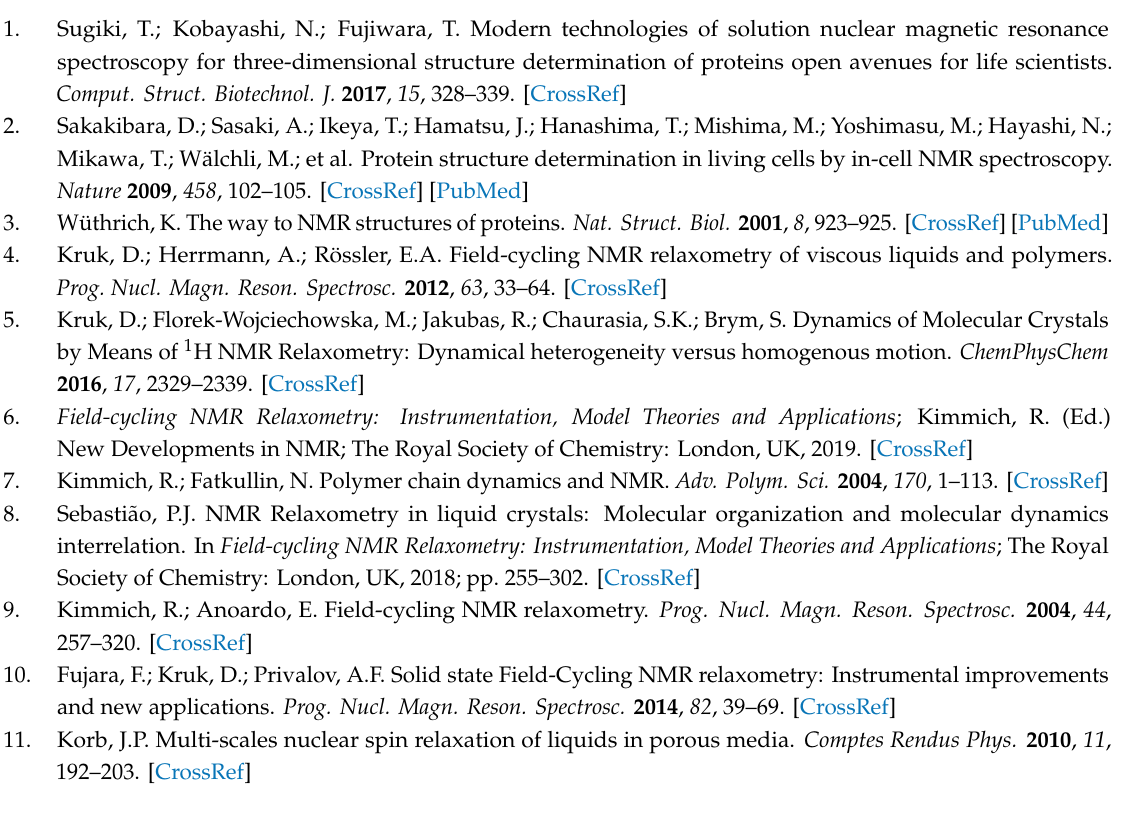
Table S1: 1 H magnetization of elastin, Table S2: 1 H magnetization of AHP, Table S3: 1 H magnetization of BSA, Table S4: 1 H magnetization of